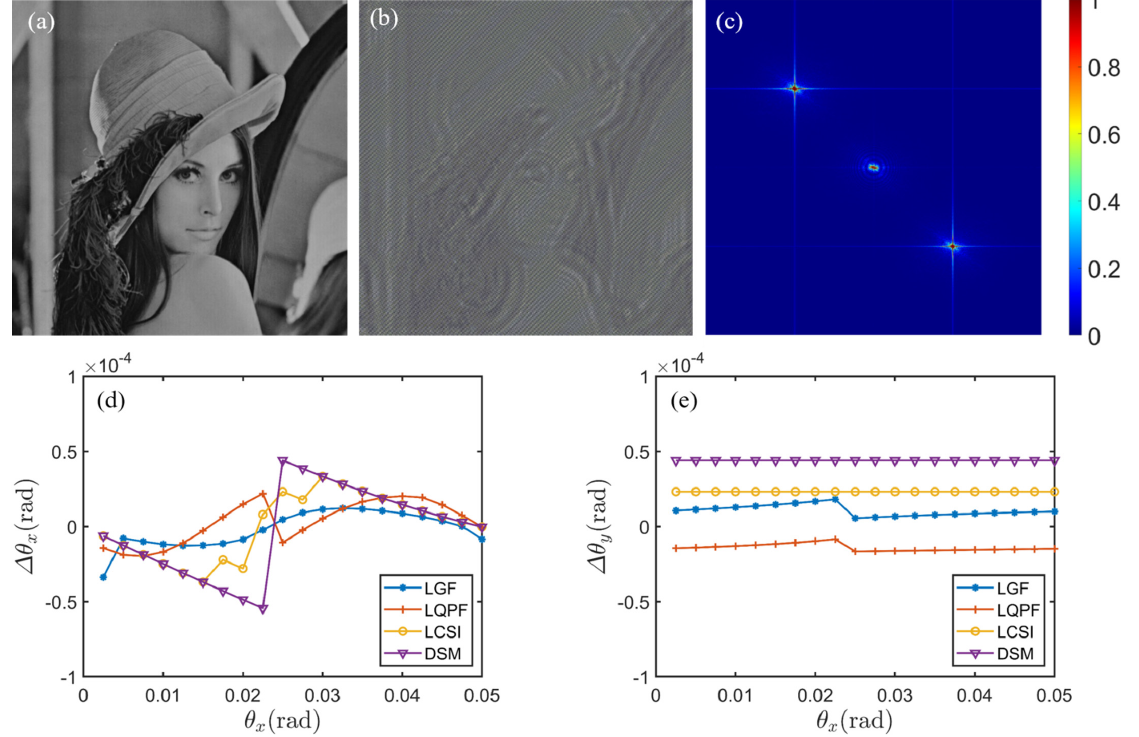
Figure 4. Spectra distribution of one real hologram and comparison of the result from LGF with that from other RTA evaluation methods ( a ) original object ( b ) hologram ( c ) corresponding spectrum distribution. ( d ) Δθ x and ( e ) Δθ y distributions from four methods when θ y = 0.025 rad.